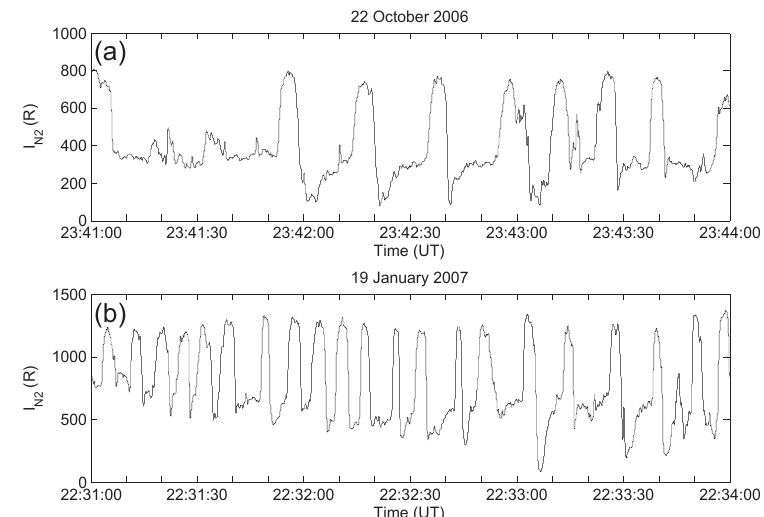
Figure 4. (a) Pc1 pulsations seen in I N during 3min on 22 October 2006. At the beginning of most OFF periods the emission brightness 2 dips below the diffuse background emission. (b) I N during 3min on 19 January 2007. Dips are again seen just after the transition from ON 2 to